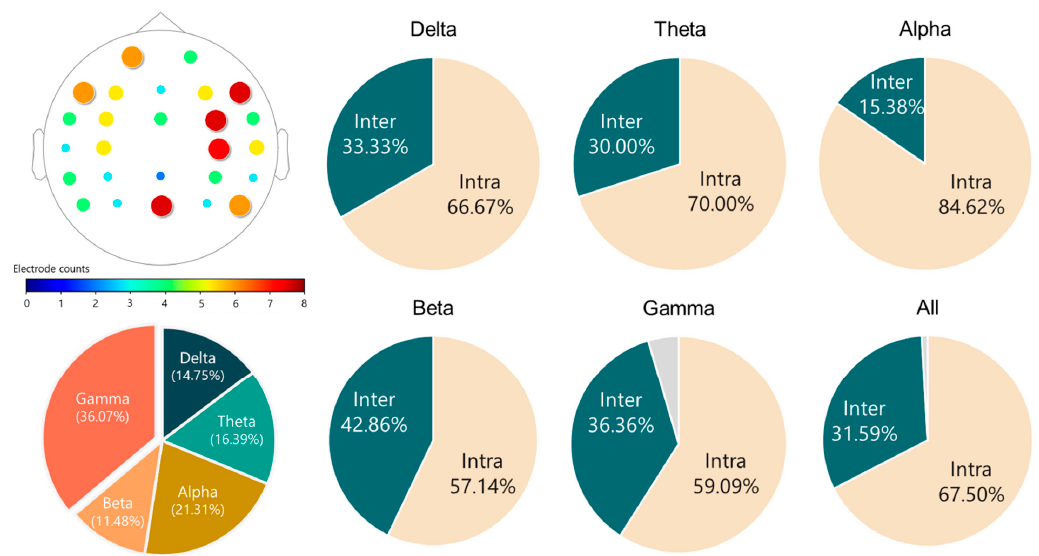
Figure 8. Characteristics of the 61 optimal coherence features selected by the SBS and SVM classifier. Upper-left: The occurring times of each electrode in the 61 features. Bottom-left: Proportion of each band in the 61 features. Remaining: Proportions of the intra-hemispheric (Intra) and inter-hemispheric (Inter) coherence features in each band. The gray part represents the regional connectivity of the electrode pair of FCz and Pz.